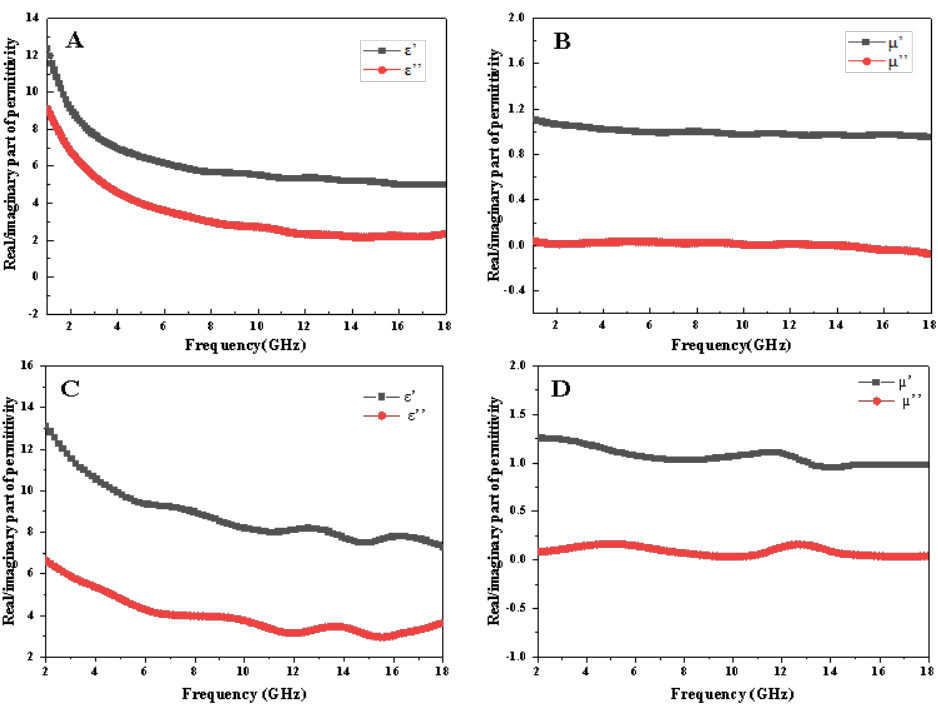
Figure 8. Dielectric constant and permeability of magnetic composite microspheres: Fe@C-12 ( A , B ) and Fe 3 O 4 @C-700 ( C , D ).